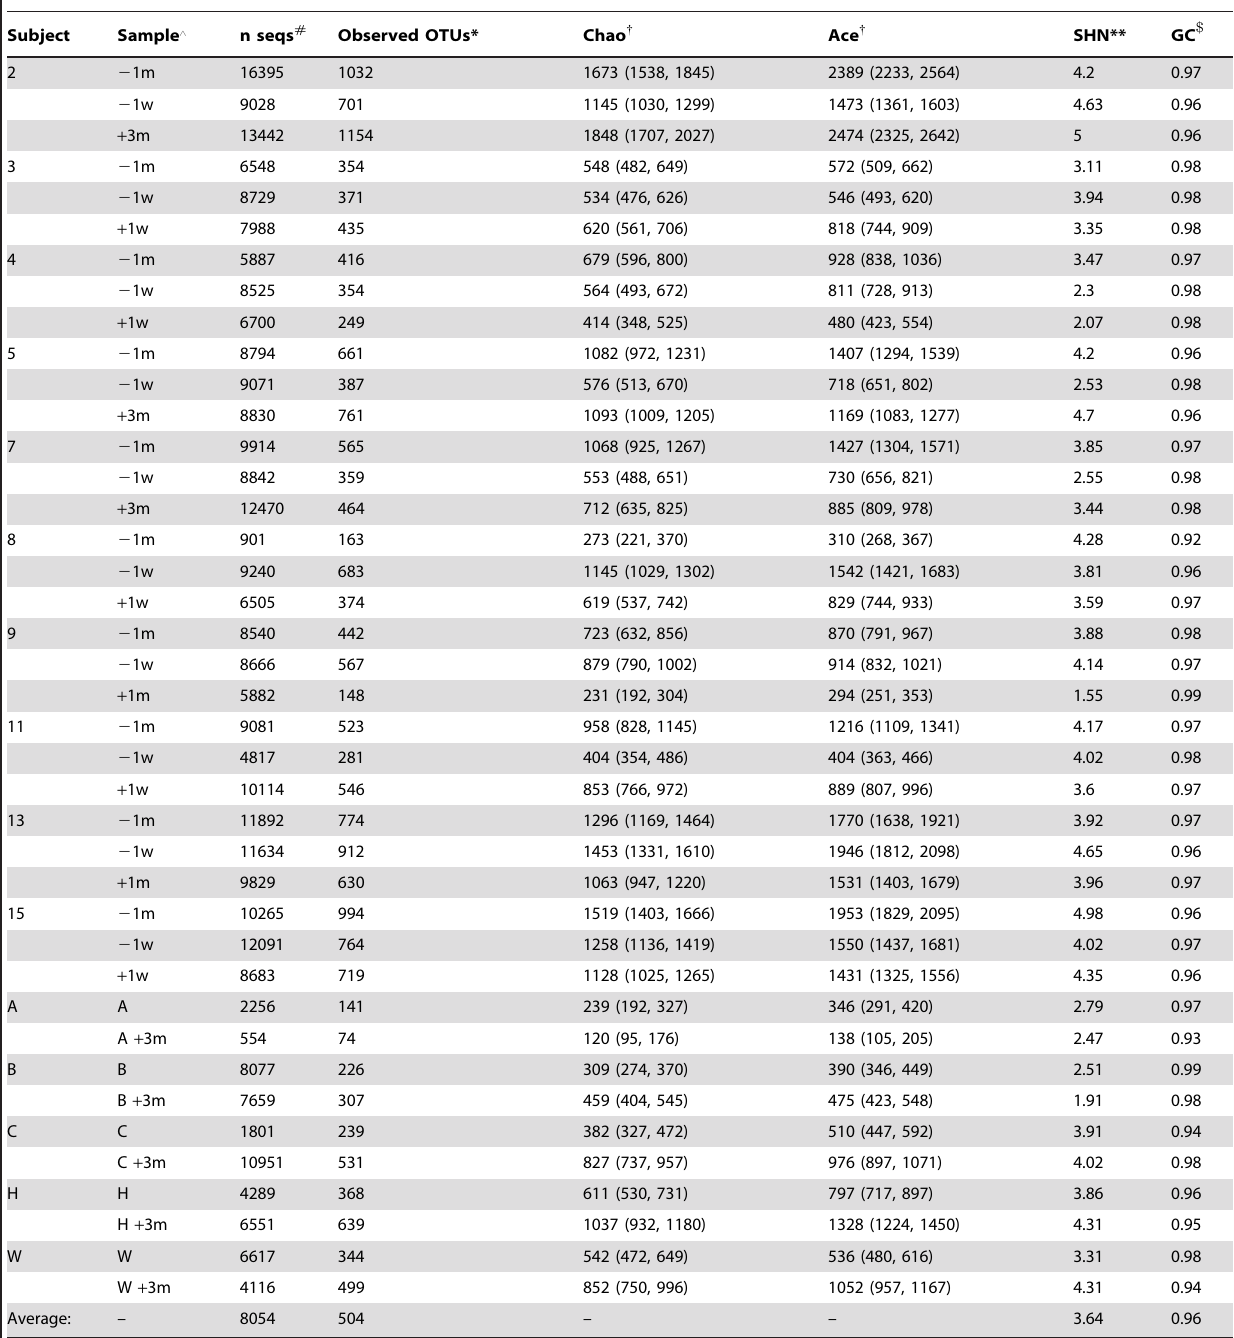
Table 2. Summary of high-throughput sequencing